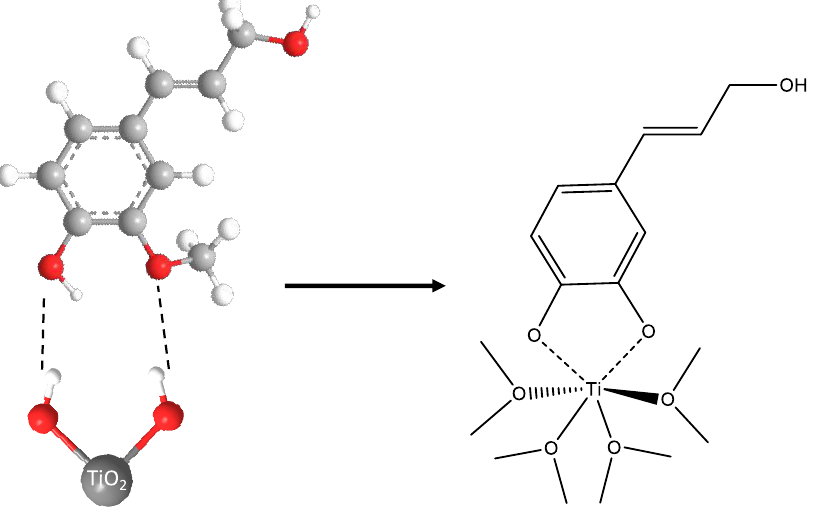
Figure 11. Fourier transform infrared spectroscopy (FTIR) of alcohol-adsorbed TiO 2 ( a ) and aromatic alcohols ( b ). alcohols ( b ).